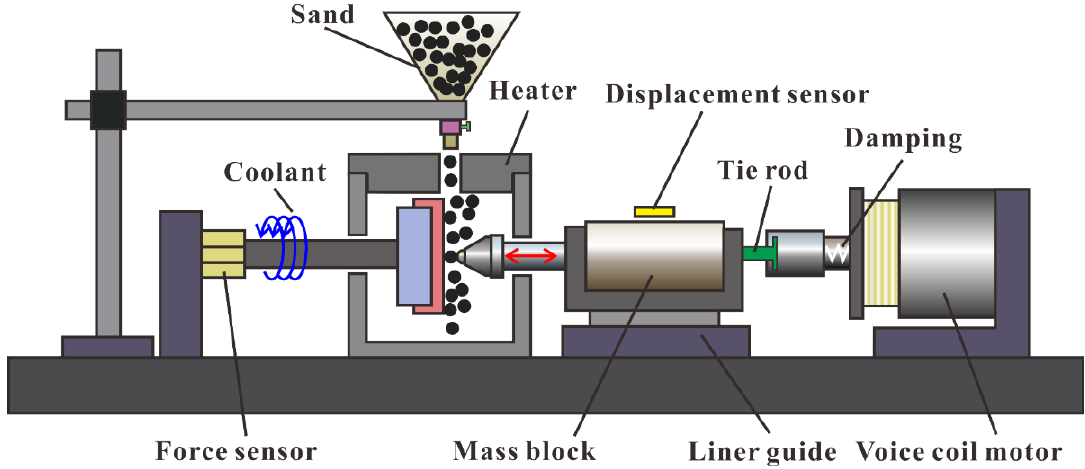
Figure 2. Schematic diagram of impact wear tester with sand at elevated temperatures. Table 1. Detailed parameters of impact wear.